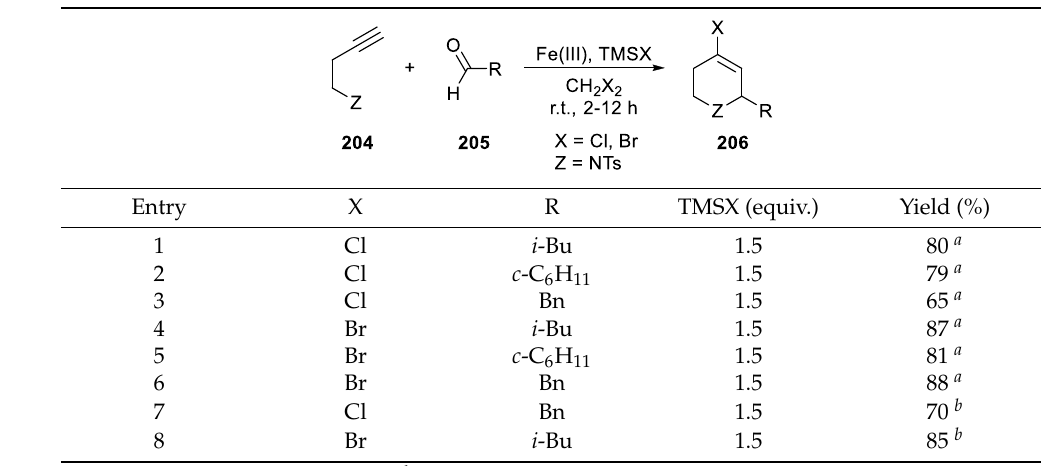
Table 5. Iron-catalyzed Prins cyclization of 4-(tosylamino)-1-butyne. Table 5. Iron - catalyzed Prins cyclization of 4 - (tosylamino) - 1 - butyne.